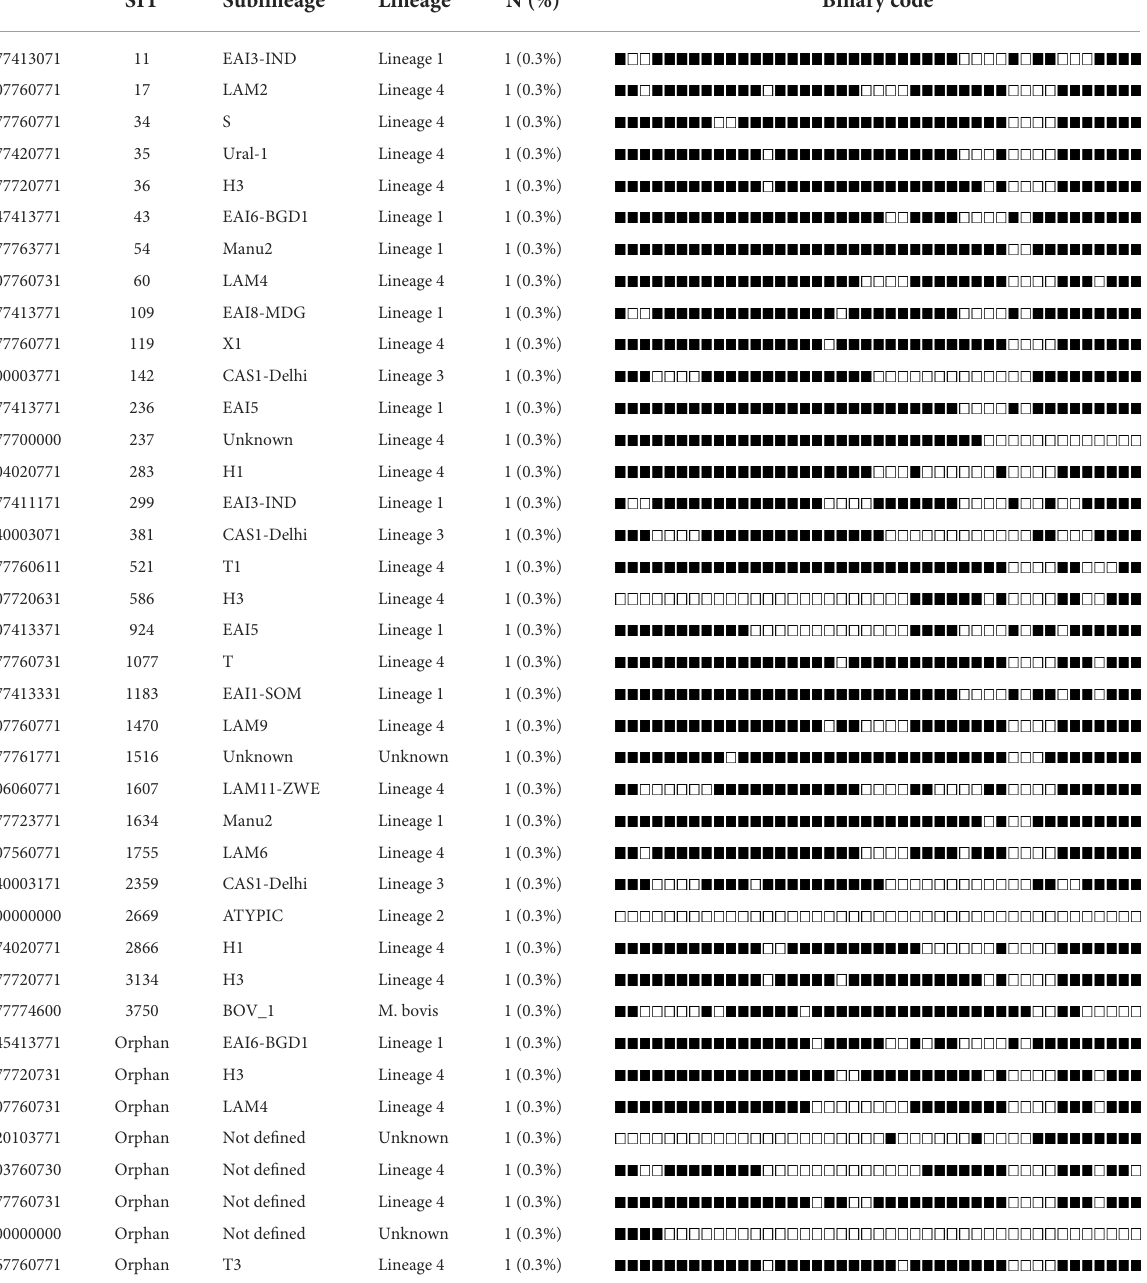
TABLE 4 Spoligotypes patterns of unique M. tuberculosis complex isolates ( n = 39) from TB patients in Somali region, Ethiopia.